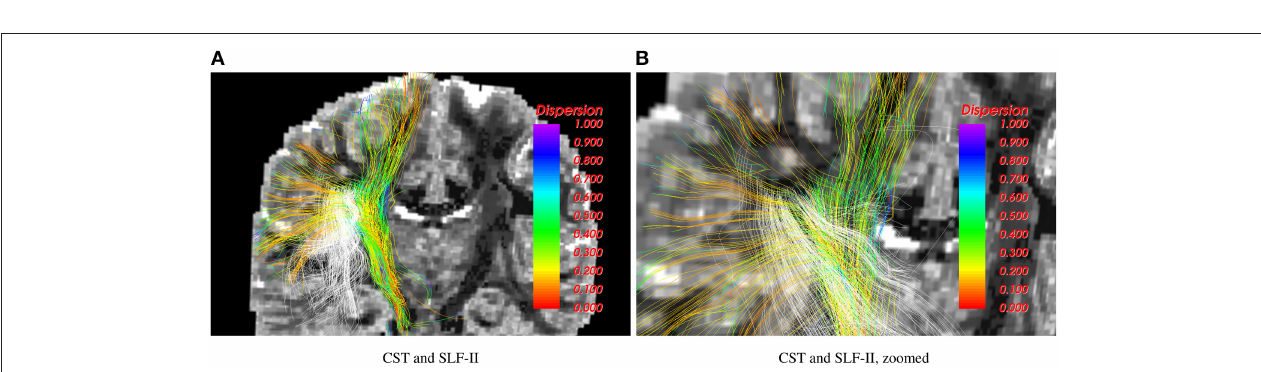
FIGURE 2 | Corticospinal tract showing orientation dispersion from two different views. In the sagittal view, the background is FA, while in the coronal view the 1-fiber NODDI dispersion map (Daducci et al., 2015) is shown in the background.